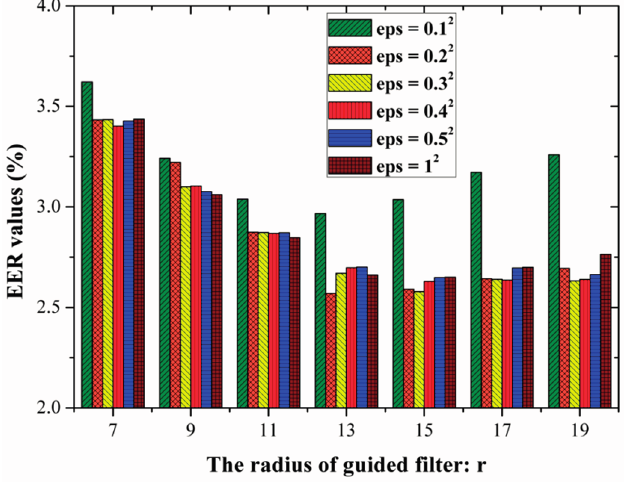
Figure 9. EER values with varying parameters. {7,9,11,13,15,17,19} r ∈ and 2 2 2 2 2 2 {0.1 ,0.2 ,0.3 ,0.4 ,0.5 ,1 } eps = ε∈